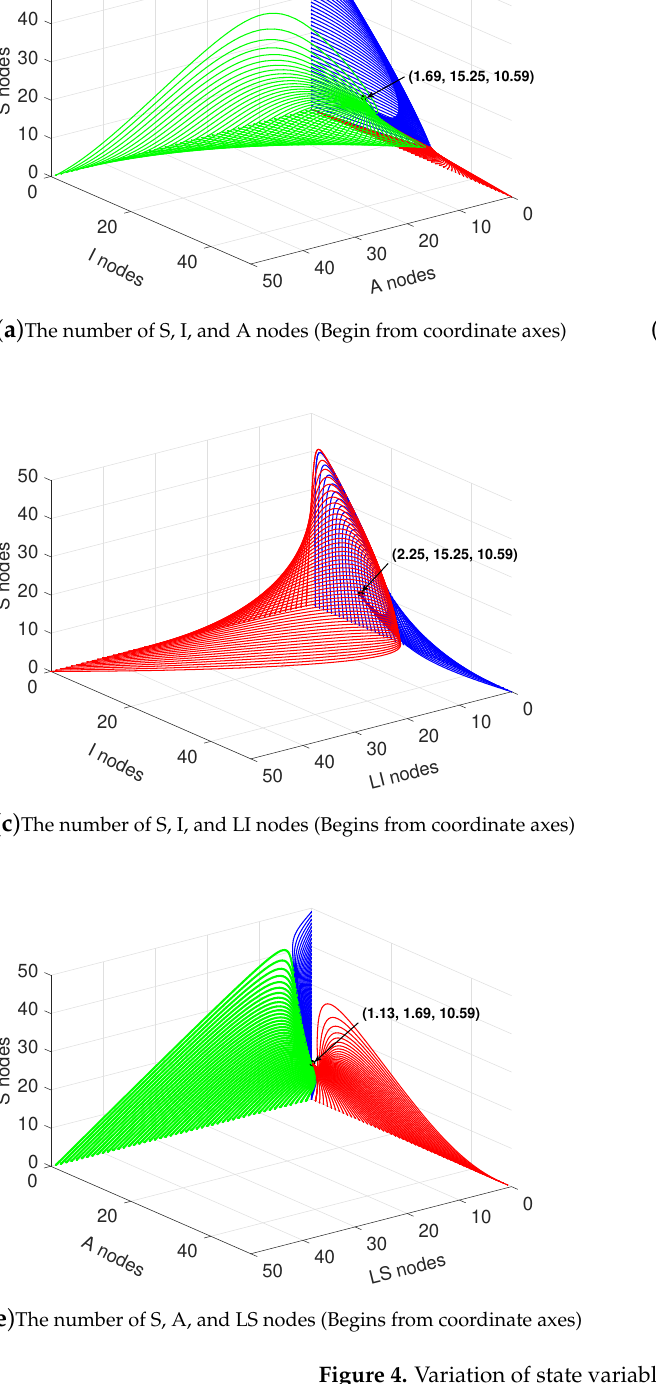
Figure 4. Variation of state variables in the case of R 0 >